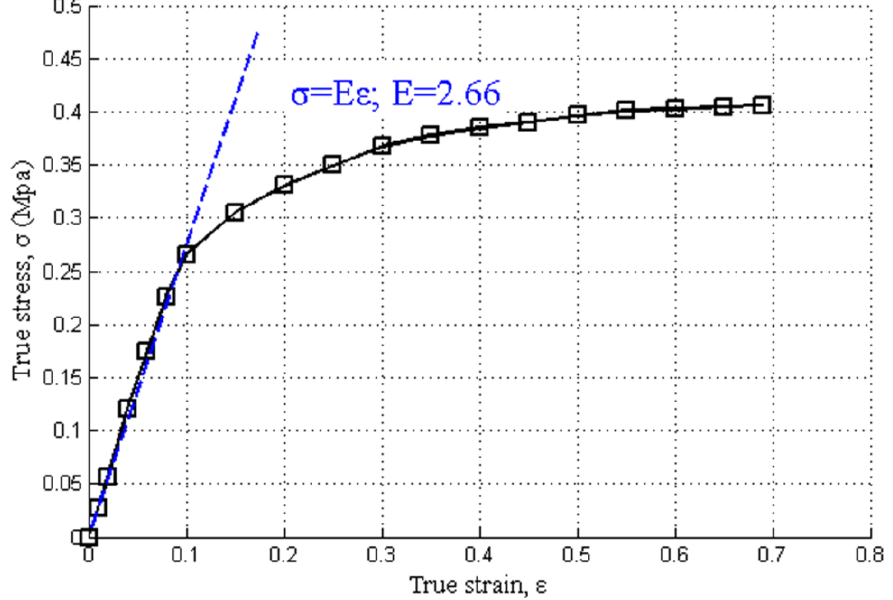
Figure 8. The true stress-true strain curve of red plasticine in our